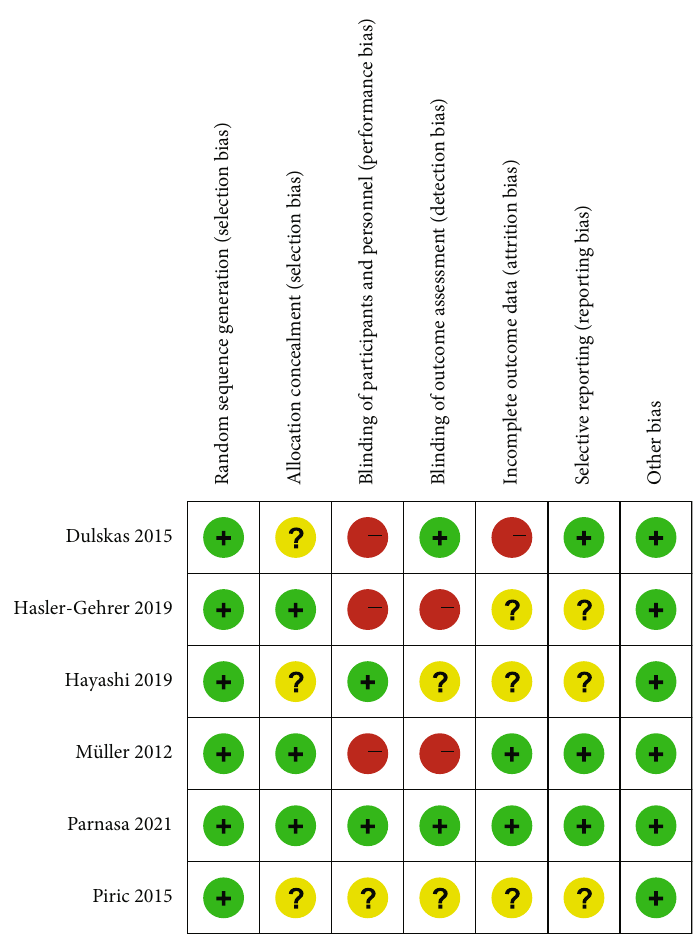
Figure 2: Risk of bias summary. Author ’ s judgement about risk of bias for each included study, presented as high (+), low (-), or unclear (?). 2015Study or subgroup Dulskas Hayashi 2019 Müller 2012 Parnasa 2021 Piric 2015 Total (95% CI) Heterogeneity: chi 2 = 0.86, df = 4 ( P = 0.93); I 2 = 0% Test for overall effect: Z = 10.66 ( P <